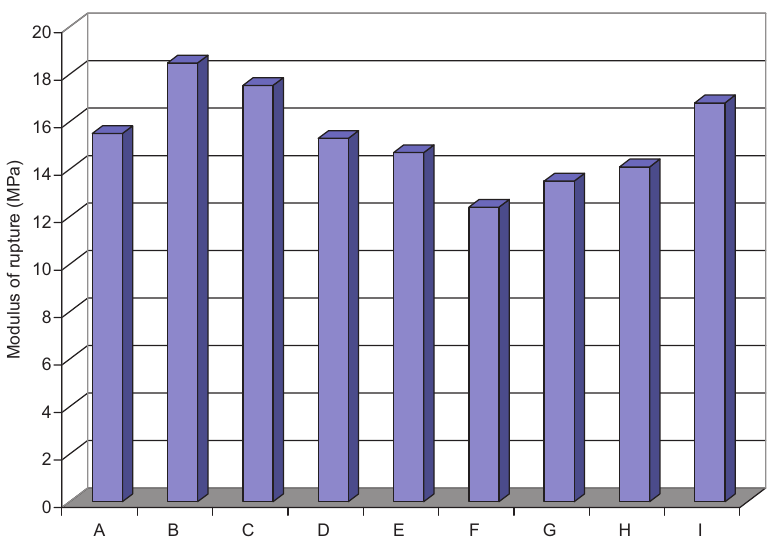
Figure 1 Bending strength of boards.